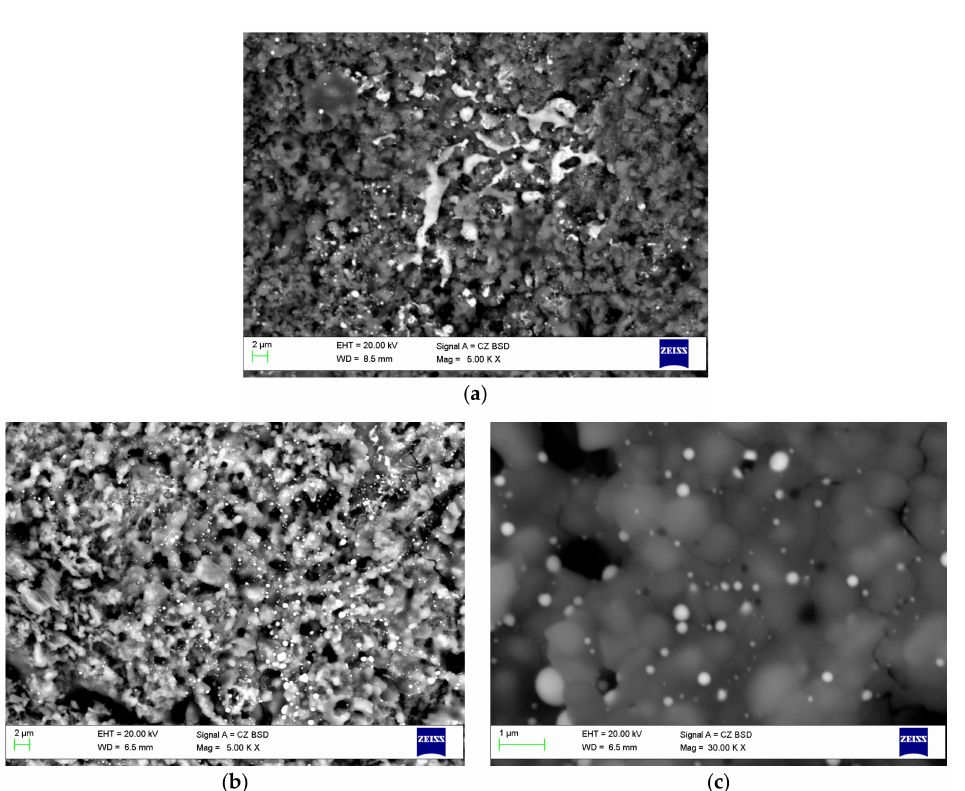
Figure 9. Surface of the TiO 2 -2.5 vol. % Ag detonation coatings obtained k = 1.1 and an explosive charge of 30% ( a ) and 60% ( b , c ) [34].